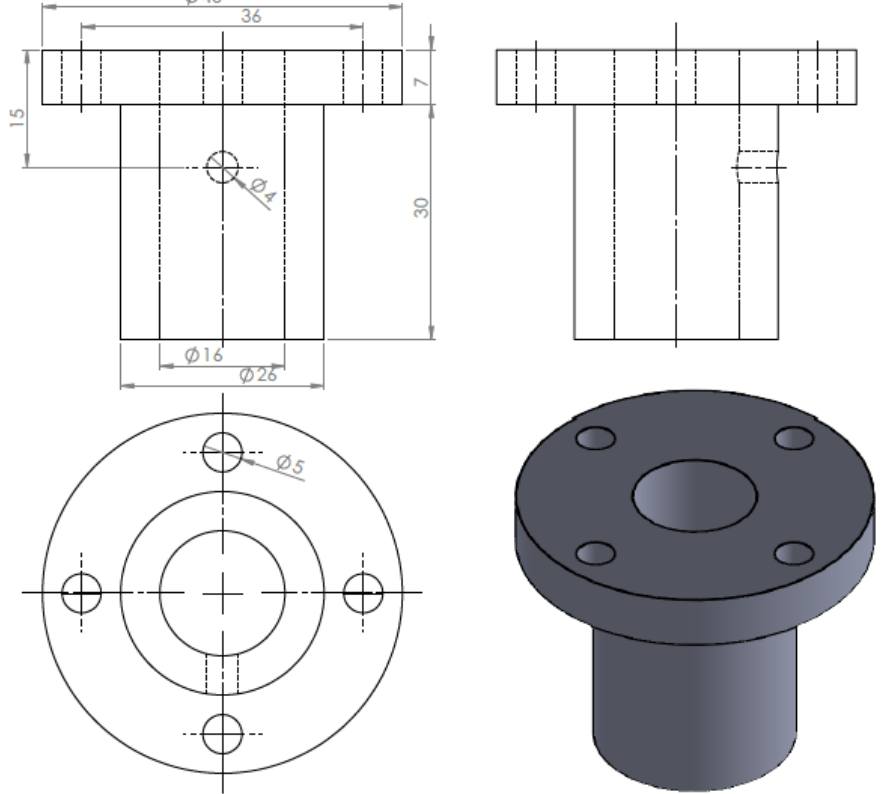
Figure 16. The drawing and isometric of the part.